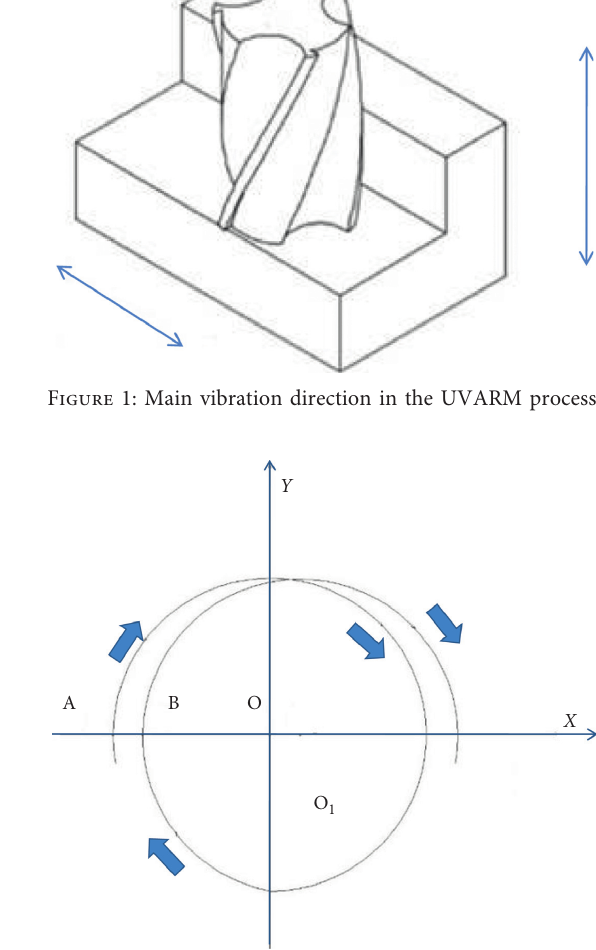
Figure 2: Path of single edge milling cutter in 1.5